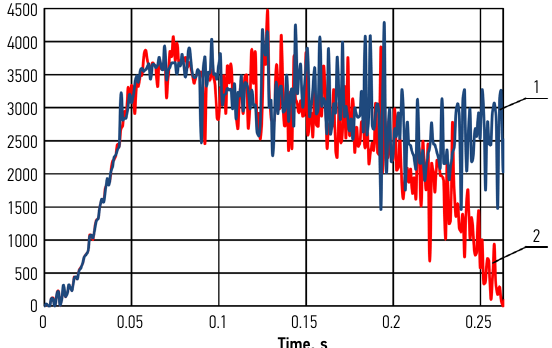
Fig. 7. Calculation results of the tire – road contact force F c in the model with water, when driving speed is 110 km/h: 1 – thickness of water film is 5 mm; 2 – thickness of water film is 10